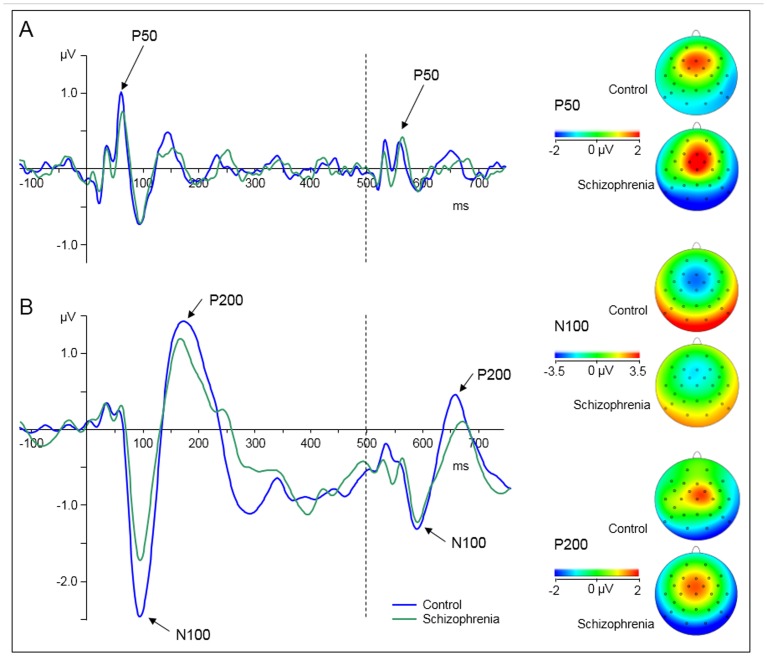
Grand averaged event-related potential waveforms elicited by auditory click-conditioning stimuli for healthy controls (blue line) and schizophrenia patients (green line) pooled across electrodes Fz and Cz.Onset of stimuli is at 0 ms (first click, solid line) and at 500 ms (second click, dashed line). Click-conditioning stimuli evoke a P50 component (A) and a N100/P200 component complex (B). Topographic maps are given for the maximum amplitude of the P50, N100 and P200 amplitude elicited by the first click stimuli for both groups.